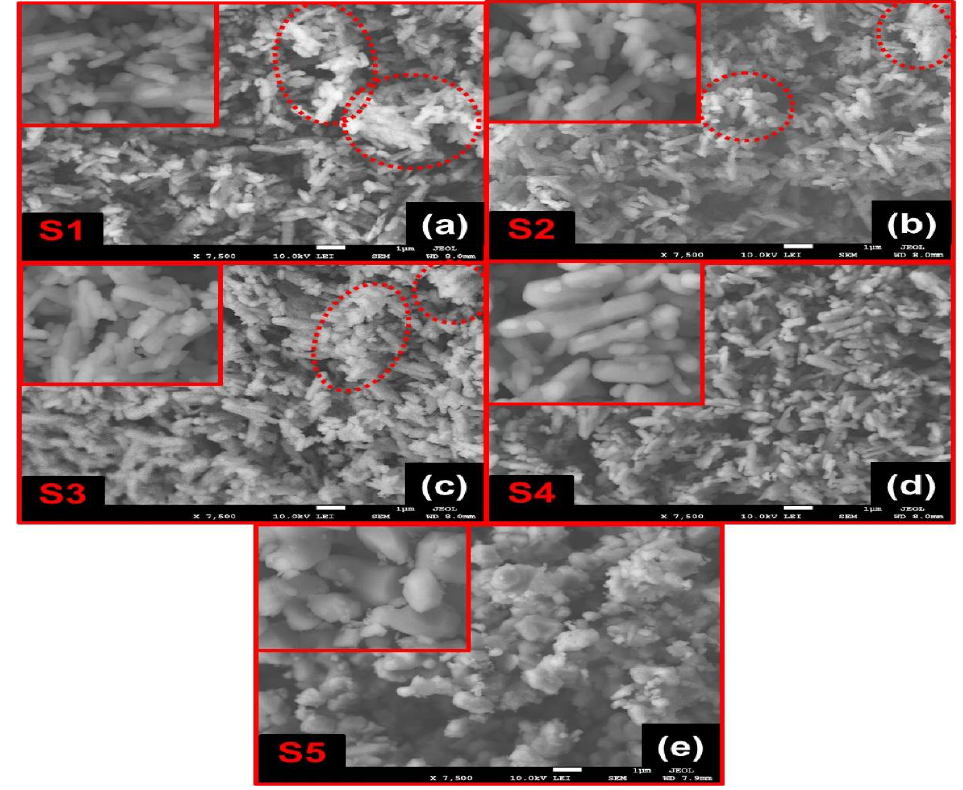
Figure 16. FESEM images of Sr-based nanomaterials calcined at different temperatures for ( a ) S1 (60 °C); ( b ) S2 (200 °C); ( c ) S3 (400 °C); ( d ) S4 (600 °C); and ( e ) S5 (800 °C). Insets show a higher- (60 ◦ C); ( b ) S2 (200 ◦ C); ( c ) S3 (400 ◦ C); ( d ) S4 (600 ◦ C); and ( e ) S5 (800 ◦ C). Insets show a higher- magnification of materials